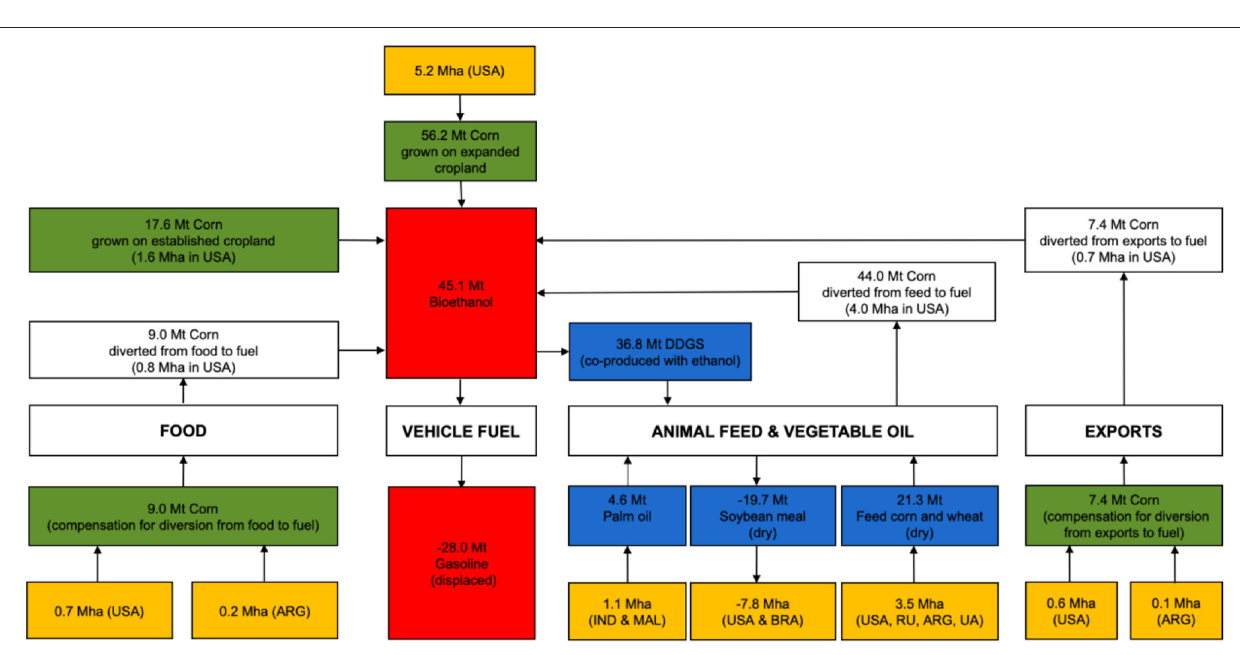
are displaced, and 21.3 Mt of feed-energy crops will